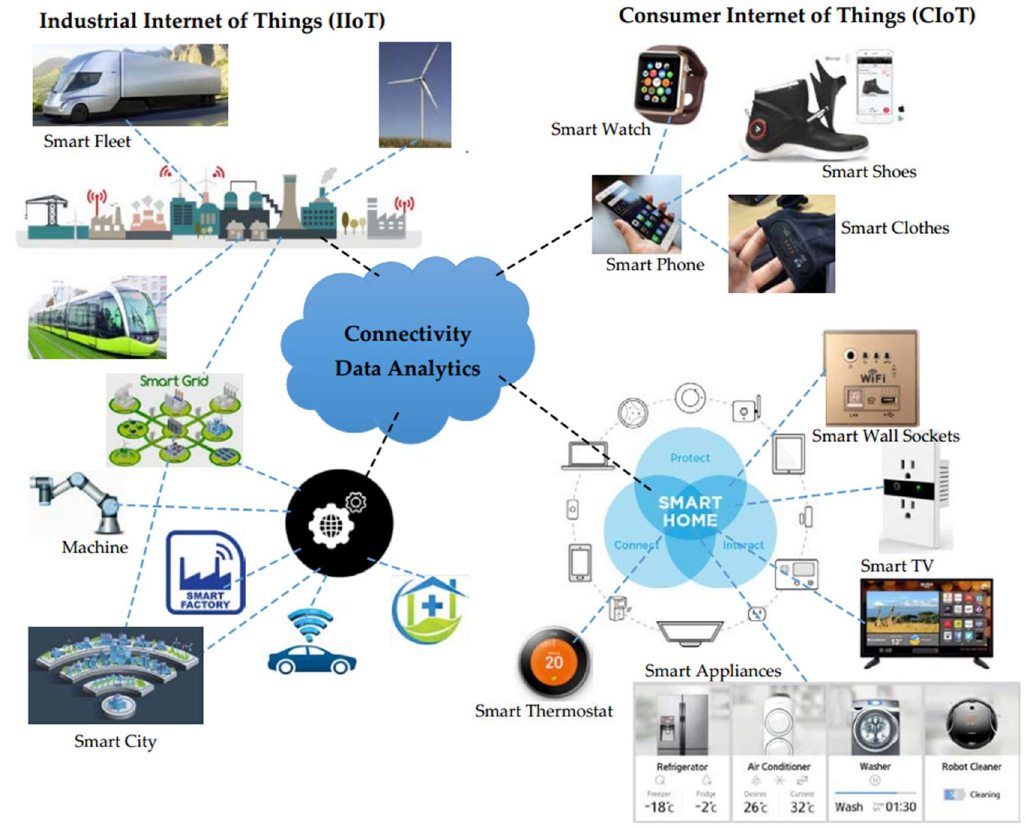
Figure 2. IIoT and CIoT, adapted from Moor Insights & Strategy’s Report [6].